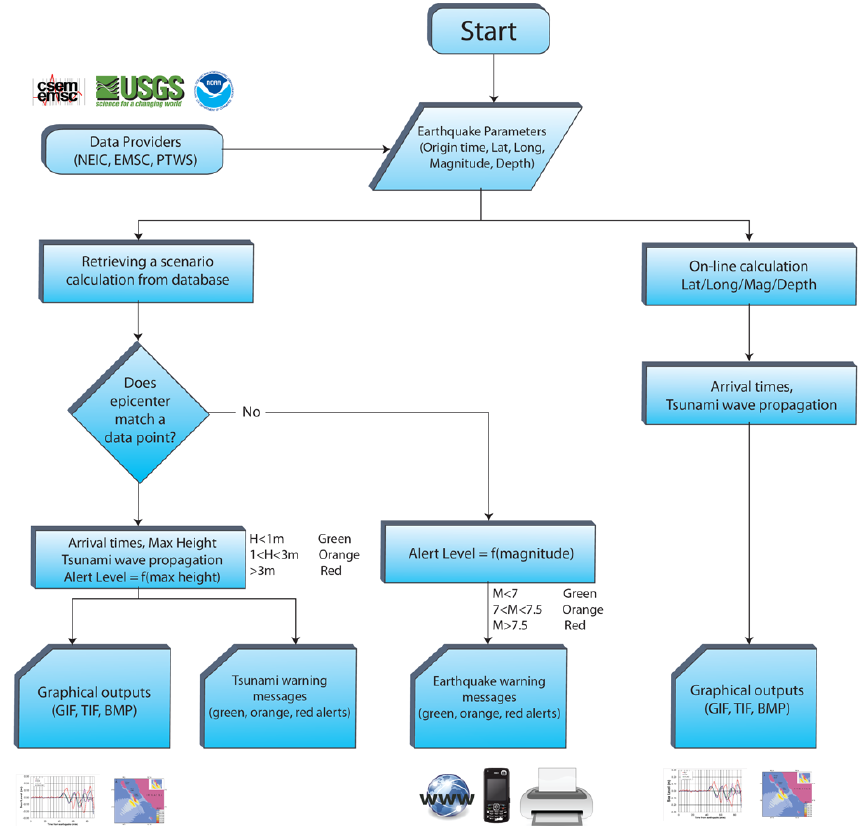
Fig. 5. Flowchart of earthquake and tsunami alert web application in GDACS.